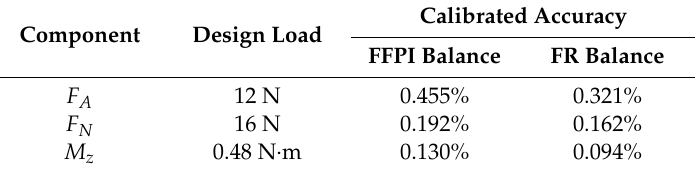
Table 3. Calibration performances of the FFPI balance, compared with a traditional foil resistive (FR) balance.